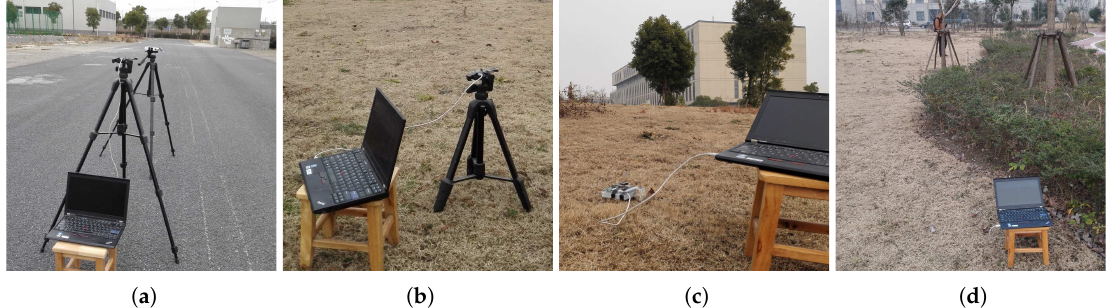
Figure 1. Measurement scenarios: ( a ) flat concrete road; ( b ) flat grass; ( c ) undulating grass; and ( d ) flat grass with